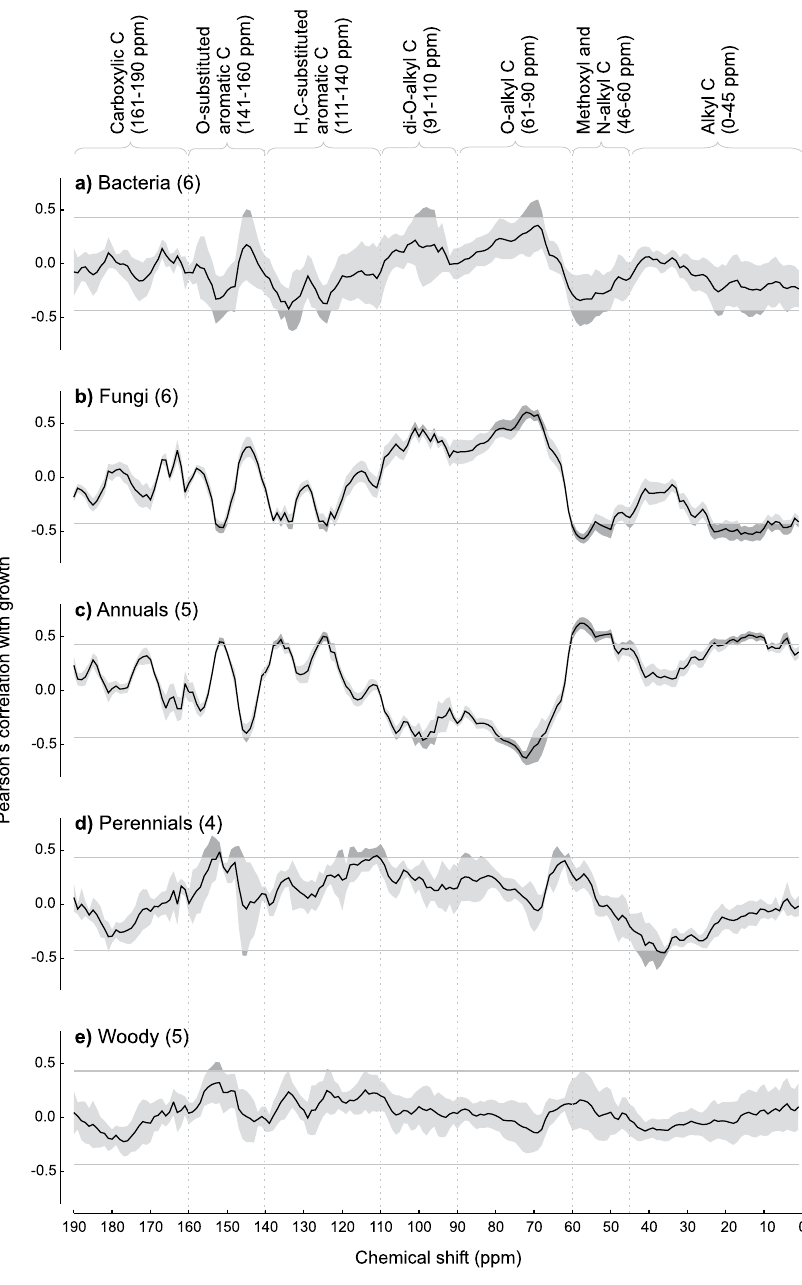
Figure 4. Correlation profiles between the growth of different organisms (bacteria, fungi, annual plants, perennial plants, woody plants) over 36 different litter materials (i.e. fresh and decomposed leaves from 18 species) and 13 C-CPMAS NMR spectral signals of the same materials. In each panel, vertical dashed lines refer to main classes of organic C. Horizontal gray lines indicate threshold values for significant correlation ( p < 0.01 after controlling for multiple comparison according to Benjamini and Hochberg 74 ). Data refer to Pearsons’ r , with mean (solid line) and 95% confidence interval (filled bands) calculated over a different number of target species within each organism type (in brackets). Significant r values are highlighted in dark